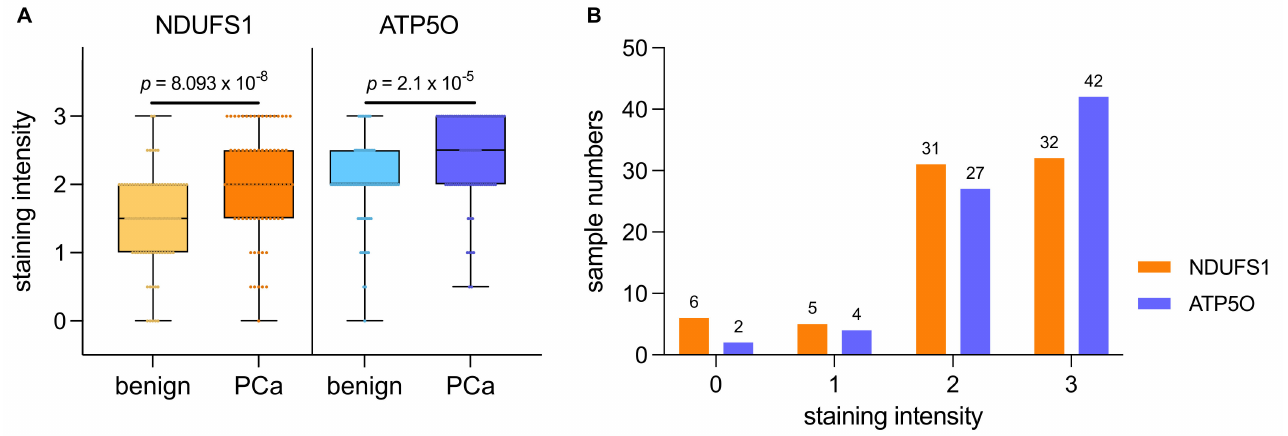
Figure 3. ( A ) IHC staining intensities for NDUFS1 and ATP5O ranging from 0 to 3 in PCa samples and adjacent be- nign tissue. Boxplots show the interquartile range with horizontal line as median, whiskers as upper and lower limits. ( B ) Histogram of staining intensities for NDUFS1 and ATP5O ranging from 0 to 3 in PCa samples. Value 0 includes staining of 0 and 0.5, value 1 includes staining of 1 and 1.5, and value 2 includes staining of 2 and 2.5.